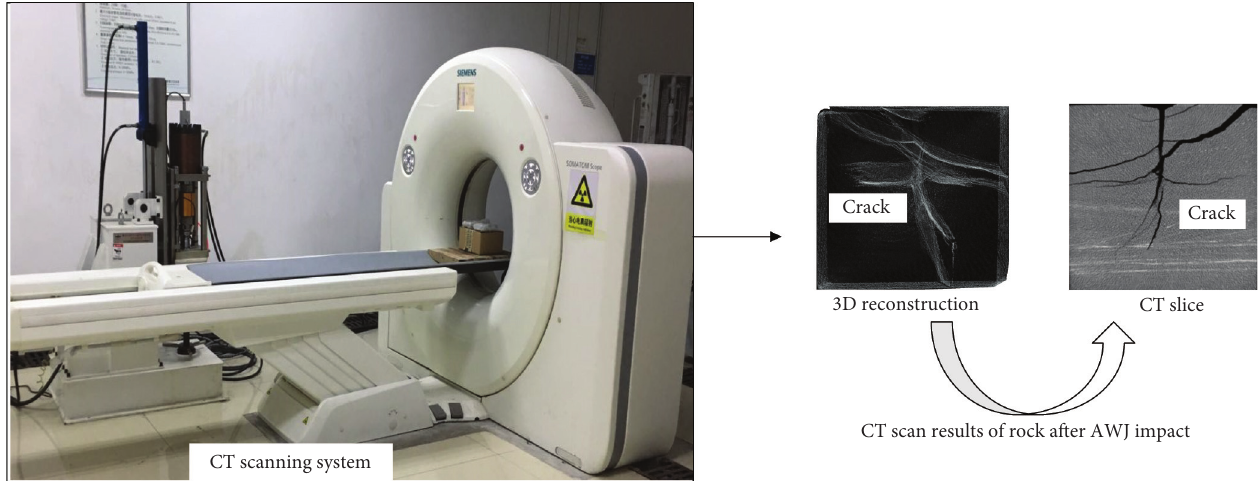
Figure 3: CT scanning system and the results.